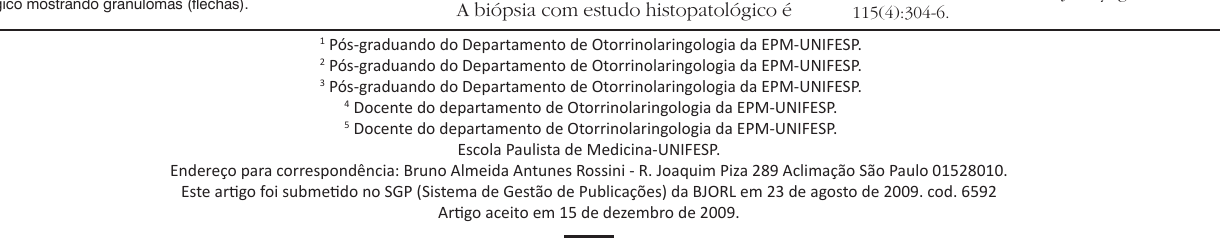
Figura 1. A- Tomografia de osso temporal direito mostrando velamento da fenda timpânica; B-Ressonância magnética de crânio em T2 com hipersinal em mastoide direita; C- Radiografia tórax com infiltrado reticulonodular em bases; D- Estudo histo- patológico mostrando granulomas